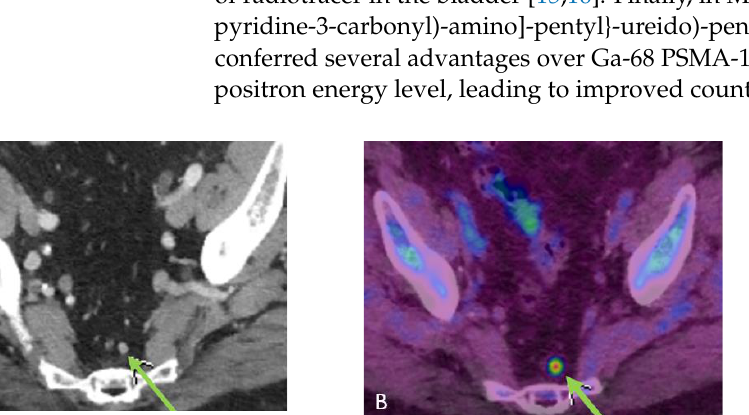
Figure 3. Seventy-year-old male with history of prostate cancer status post-prostatectomy, now presenting with rising PSA. ( A ) Contrast-enhanced CT (CECT) shows a normal-sized presacral lymph node which was presumed to be reactive. Axumin-fused PET/CT ( B ) and MIP ( C ) images show Axumin uptake within the lymph node, suspicious for recurrence and nodal disease.